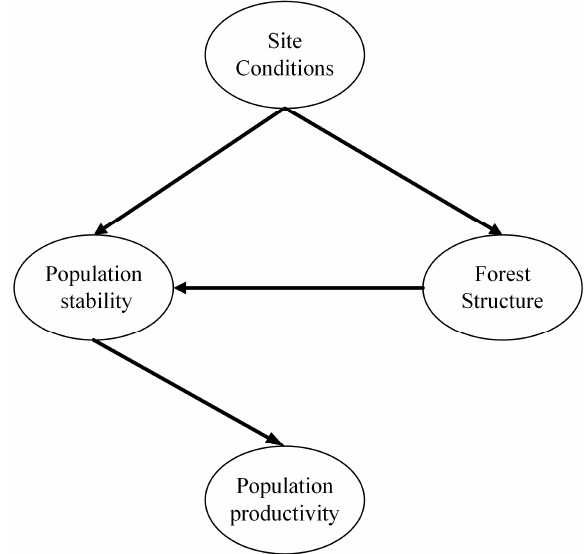
Table 5. Model fit test results